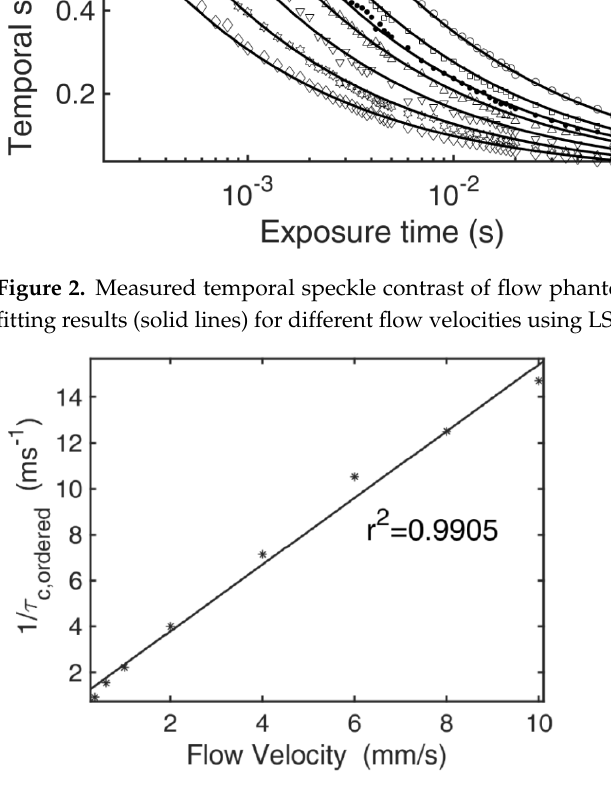
Figure 3. Dependence of fitting parameter τ c,ordered (plotted as 1/ τ c,ordered ) obtained from the speckle contrast and flow velocities. The linear correlation coefficient is 0.9905.